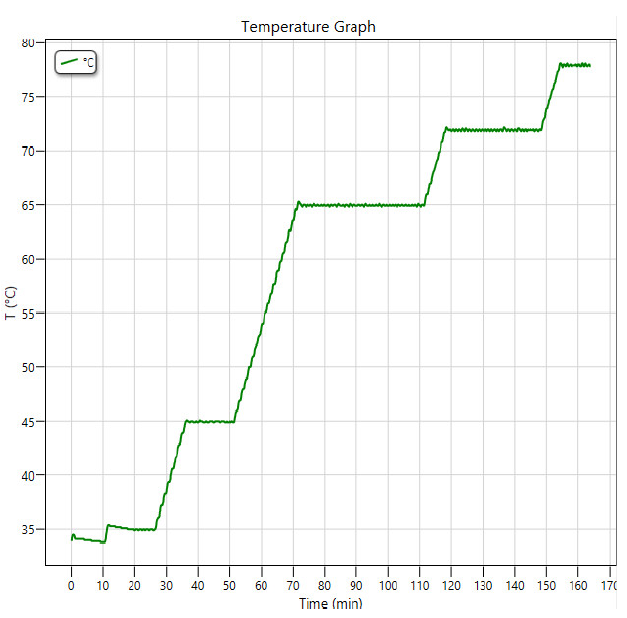
Figure 2. Modified Congress mashing.